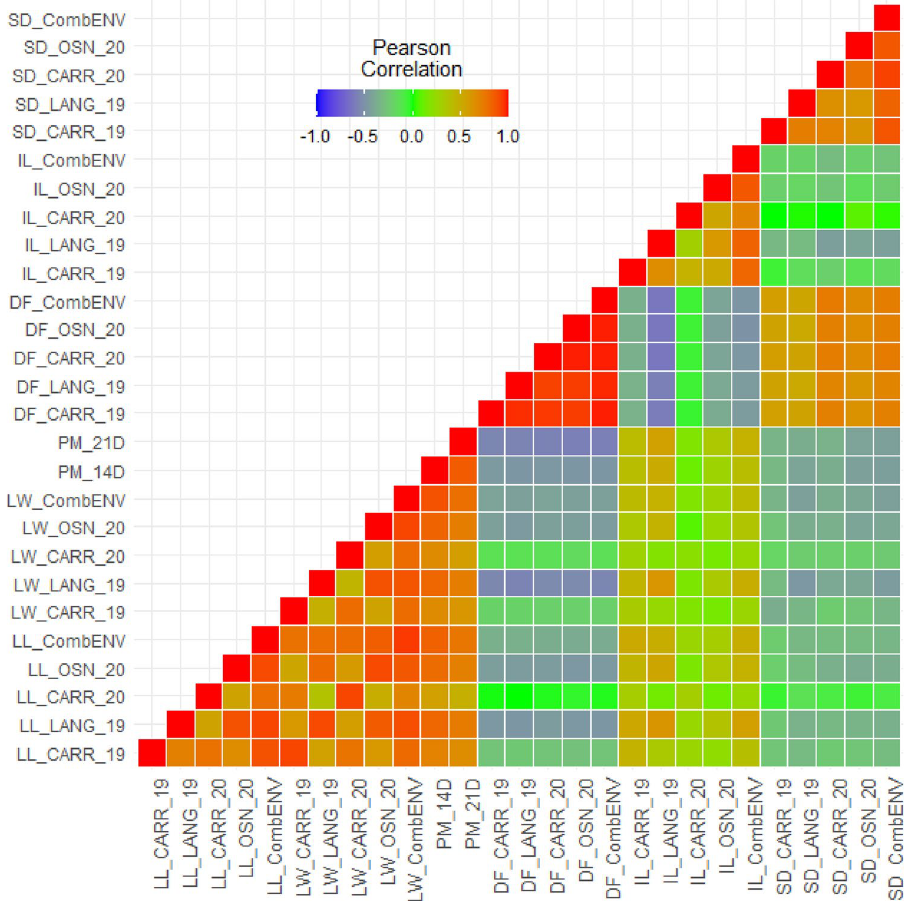
Figure 2. Correlation heatmap for different sclerotinia stem rot phenotypic traits in four environments and the combined dataset across environments. Traits: DF = days to flowering; IL = internode length; LL = lesion length, LW = lesion width, PM_14D = plant mortality at 14 days post inoculation (dpi); PM_21D = plant mortality at 21 dpi; SD = stem diameter. Environments: Carrington 2019 (CARR_19) and 2020 (CARR_20), Langdon 2019 (LANG_19), Osnabrock 2020 (OSN_20), combined across all environments (CombENV). Plant mortality are averages of all